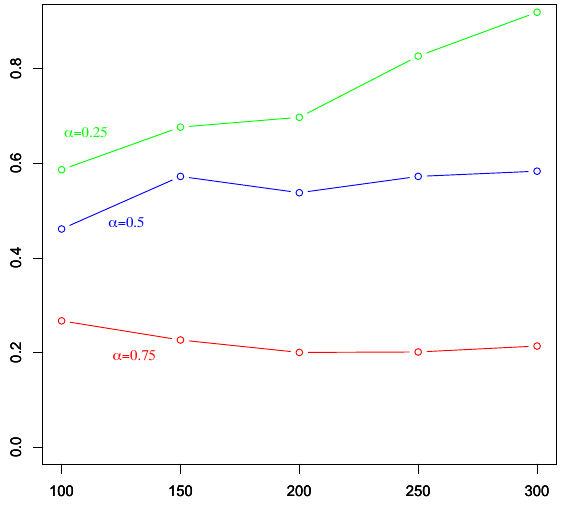
Figure 5. Approximate entropy (ApEn) of FIOU with µ = σ = 1, β = 0, for various value of α (specified by labels inside the figure) and N (on the horizontal